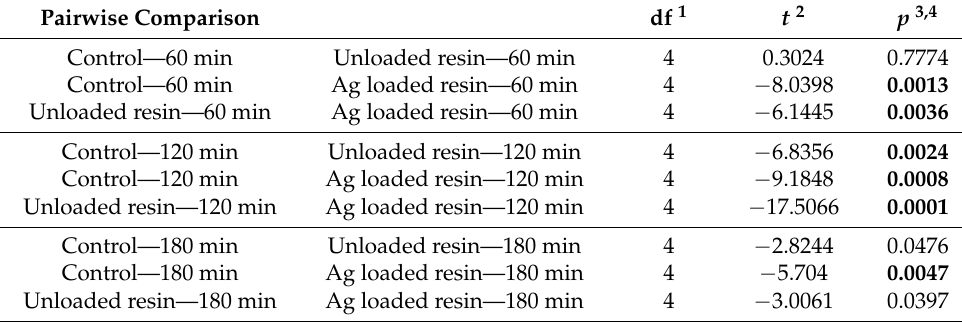
Table 2. Pairwise t -tests between time points within each growth